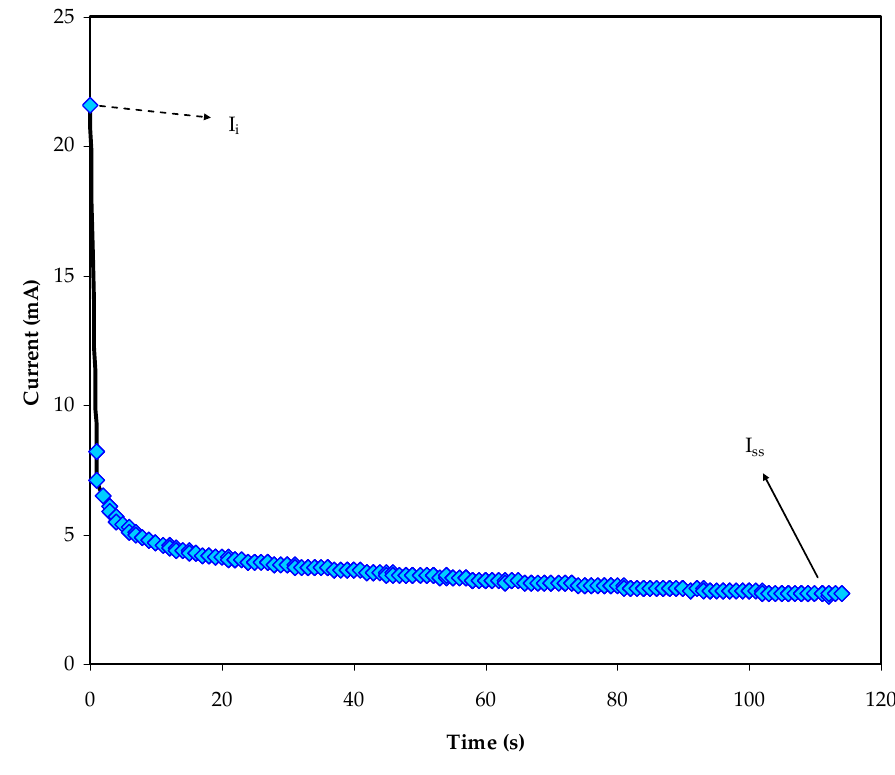
Figure 9. DC polarization curve of current versus time for the MCKI4 sample.